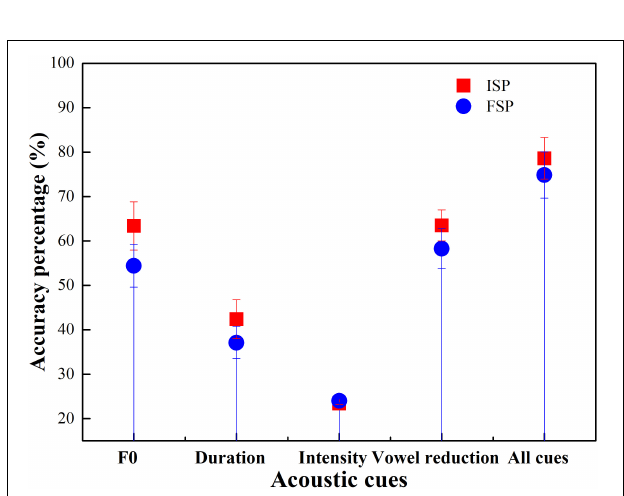
FIGURE 2 | Stimuli (A) and filler (B) sequence-encoding accuracy.